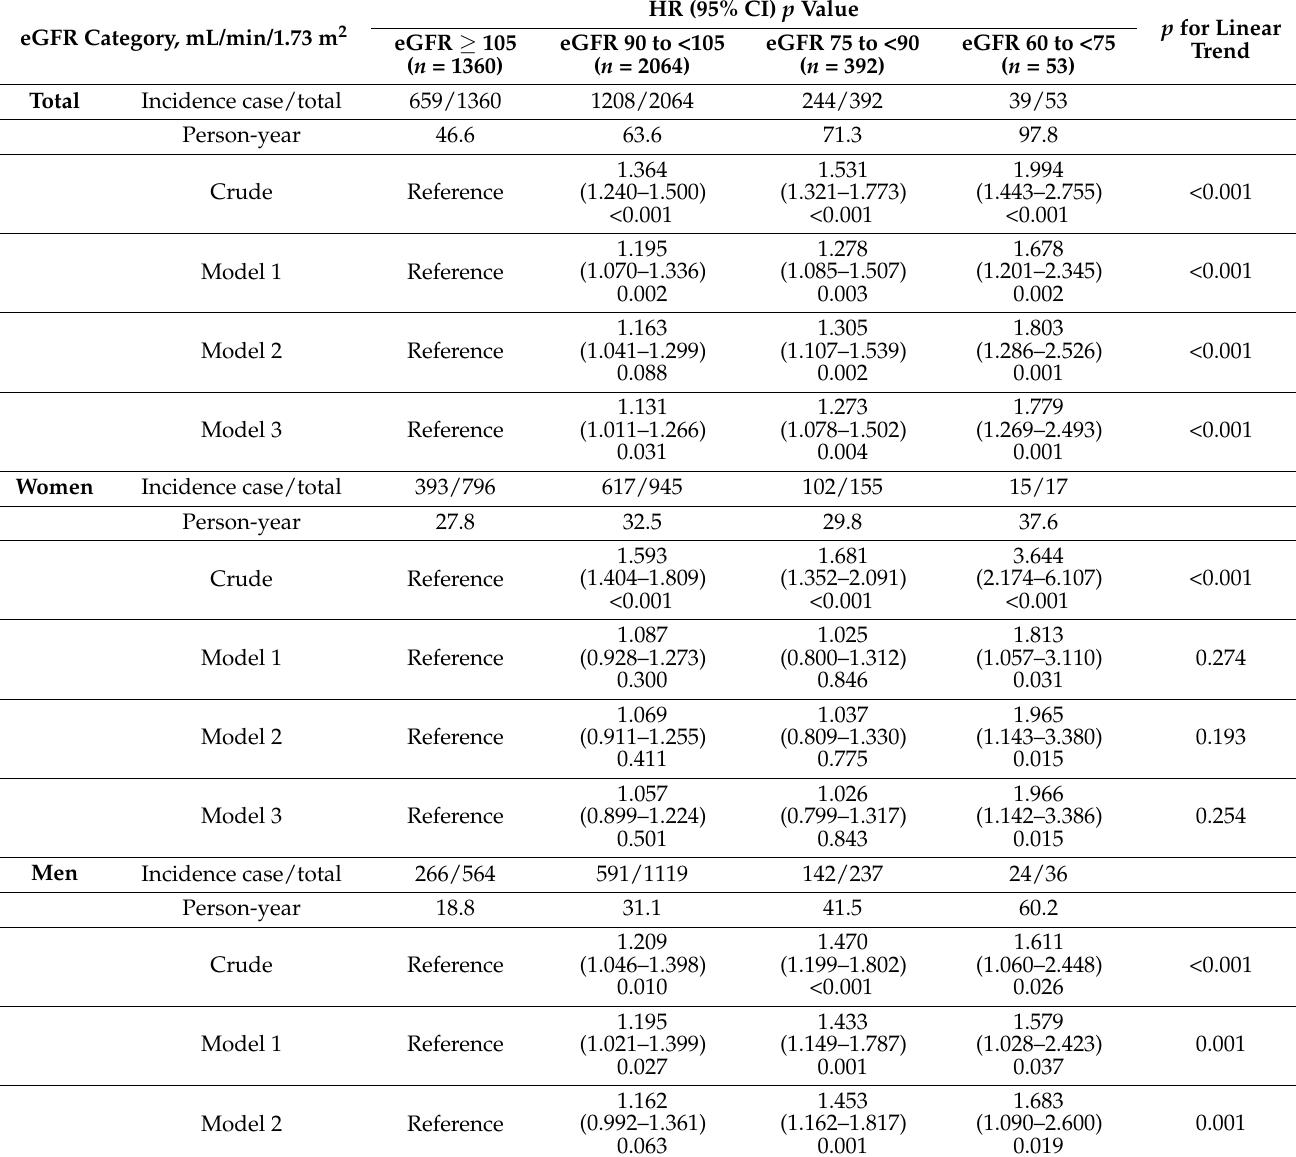
Table 2. Cox proportional hazard model of MS development based on eGFR category in the cohort follow-up